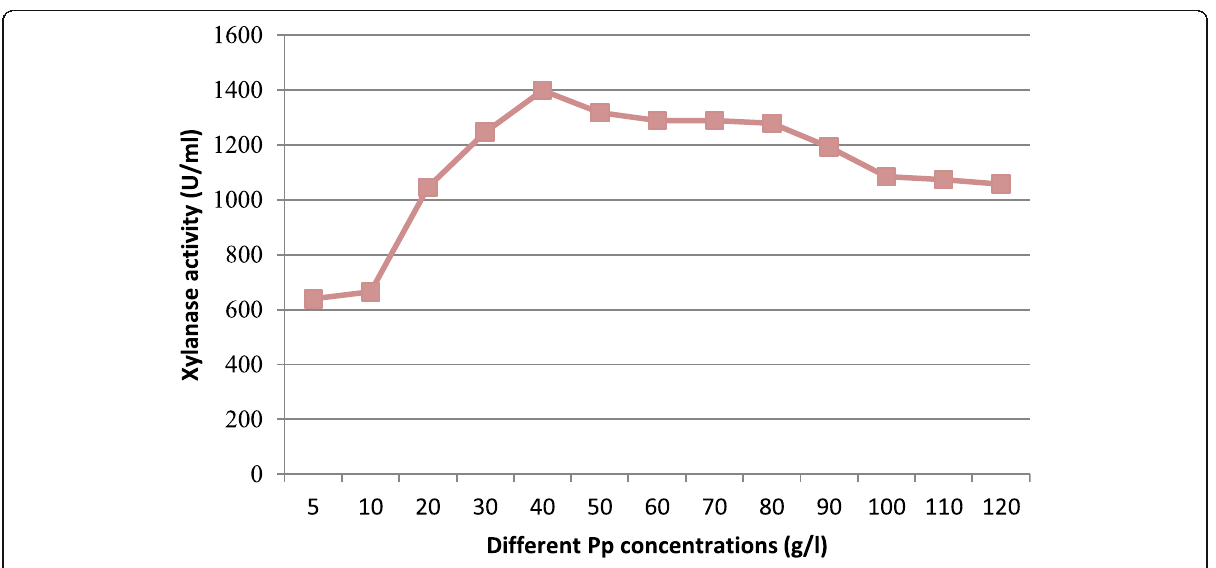
Fig. 2 Effect of different concentrations of pomegranate peel on xylanase